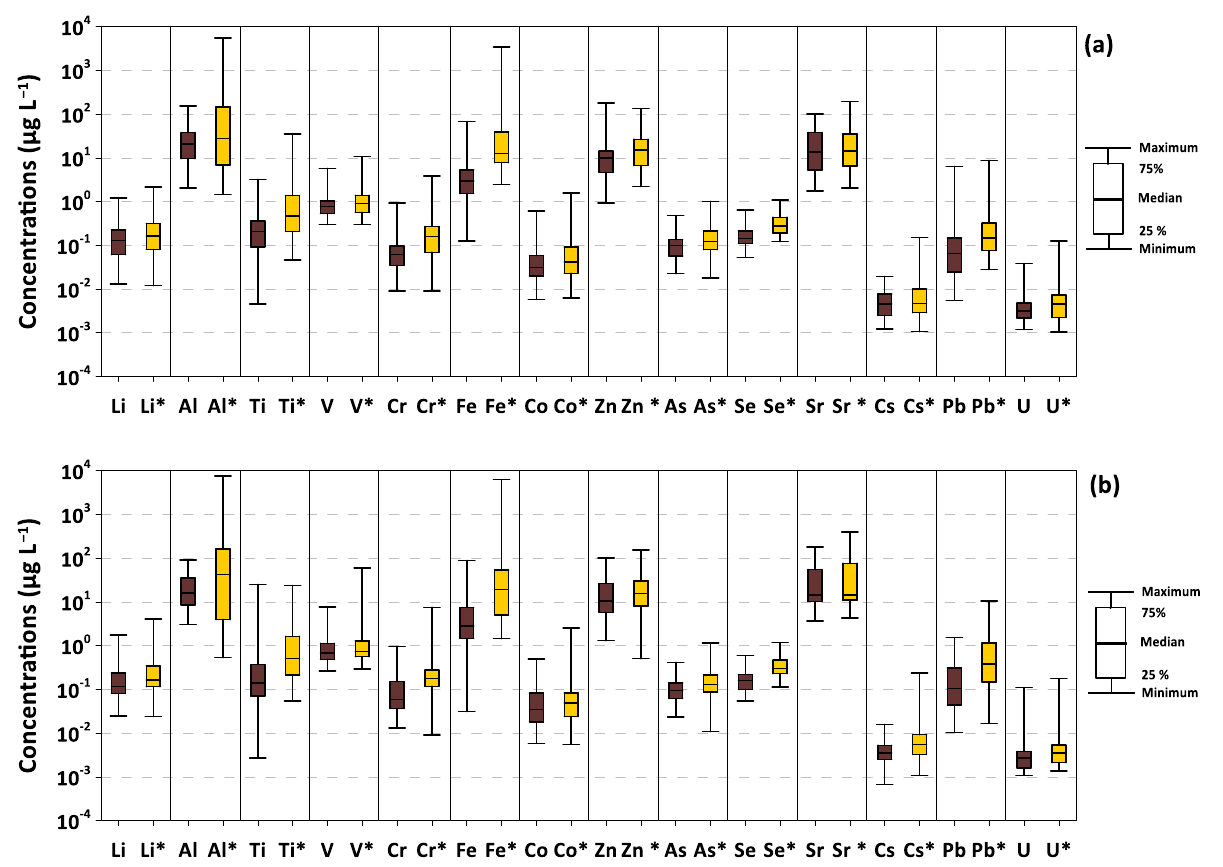
Figure 3. Box whiskers plots of the trace elements VWM concentrations (μg L −1 ) in filtered (brown), and unfiltered (*) (yellow) rainwater samples of Priolo Gargallo ( a ), and Milazzo study areas ( b ). Tellurium VWM concentration values were not listed in Table S1